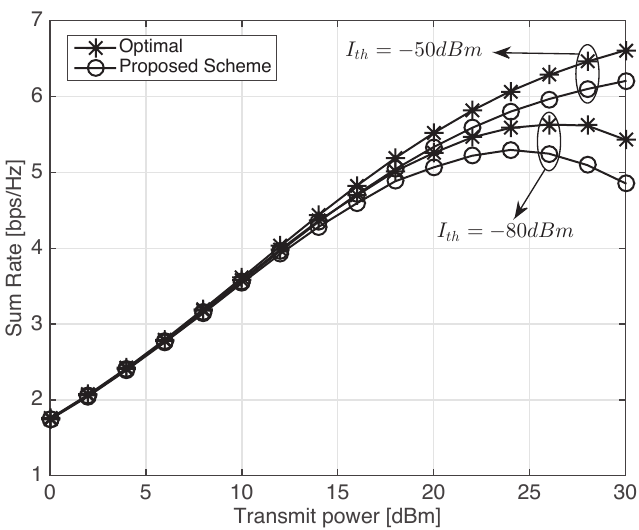
Figure 7. Average sum-rates when all channels are non- i.i.d. and N = 5.